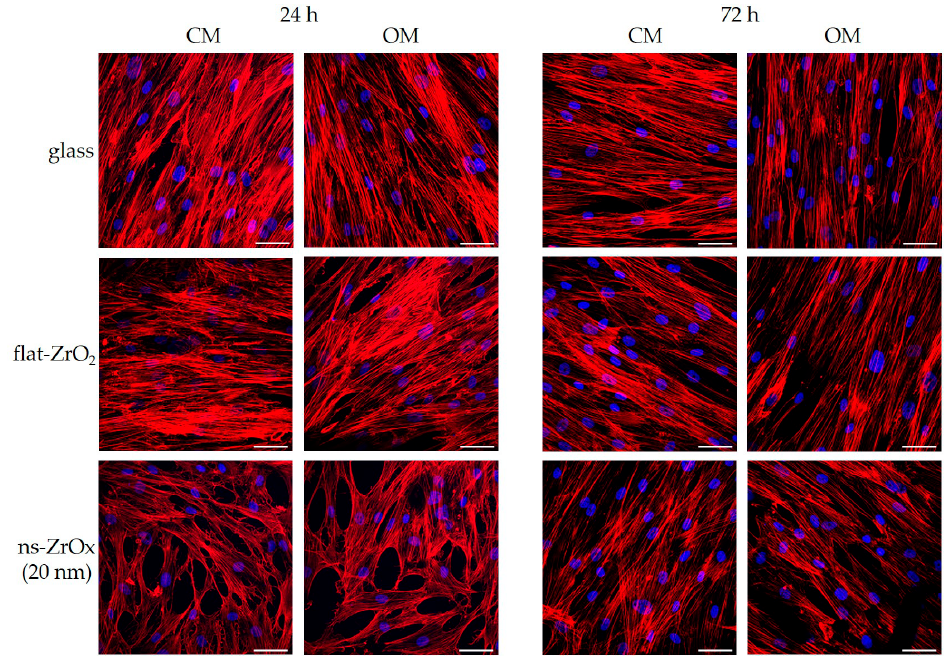
Figure 5. The effect of 20 nm ns-ZrOx substrate on the actin cytoskeleton. bMSCs were cultured in Figure 5 . The effect of 20 nm ns ‐ ZrOx substrate on the actin cytoskeleton. bMSCs were cultured in CM or OM on 20 nm ns-ZrOx, flat-ZrO 2 , and glass. After 24 and 72 h, the effects of the substrate were CM or OM on 20 nm ns ‐ ZrOx, flat ‐ ZrO 2 , and glass. After 24 and 72 h, the effects of the substrate observed through confocal microscopy after TRITC-phalloidin and DAPI staining. Scale bar: 50 µ m. were observed through confocal microscopy after TRITC ‐ phalloidin and DAPI staining. Scale bar: 50 μ m. Using the JC-1 dye, we measured mitochondrial membrane potential and found it to be significantly depolarized in bMSCs cultured for 24 h on 20 nm ns-ZrOx vs. the cells cultured on glass or flat-ZrO 2 , independent of culture conditions (Figure 8). After 72 h of longer (Figure Figure 5 . The effect of 20 nm ns-ZrOx substrate on the actin cytoskeleton. bMSCs were cultured in CM or OM on 20 nm ns-ZrOx, flat-ZrO 2 , and glass. After 24 and 72 h, the effects of the substrate were observed through confocal microscopy after TRITC-phalloidin and DAPI staining. Scale bar: 50 μ m.